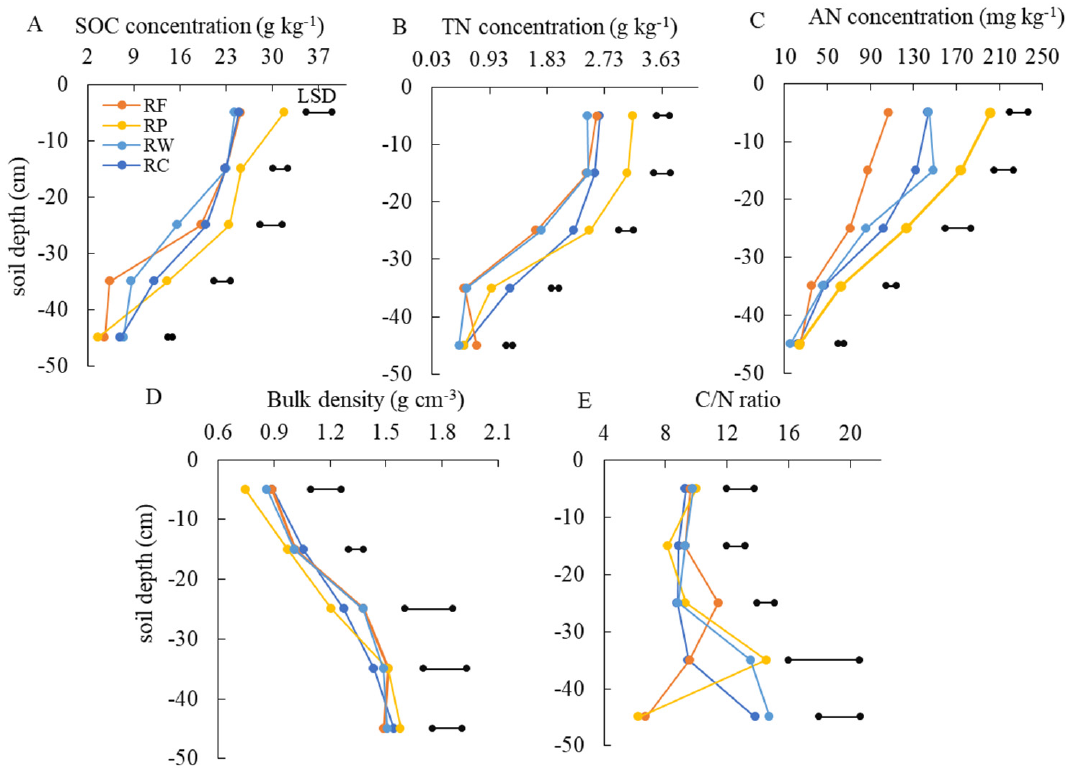
Figure 2. The vertical difference of soil organic C ( A ), total N ( B ) and available N ( C ) concentrations, ( D ) bulk density, and ( E ) C/N ratio among rotations.